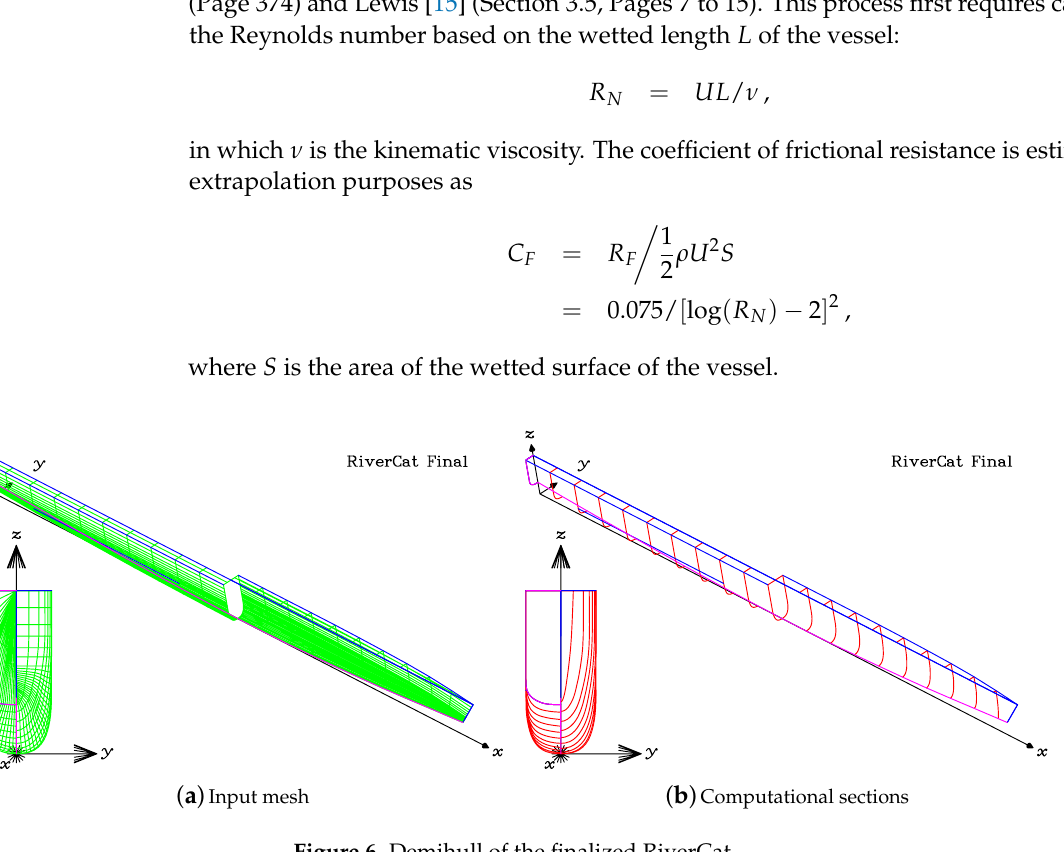
Figure 6. Demihull of the finalized